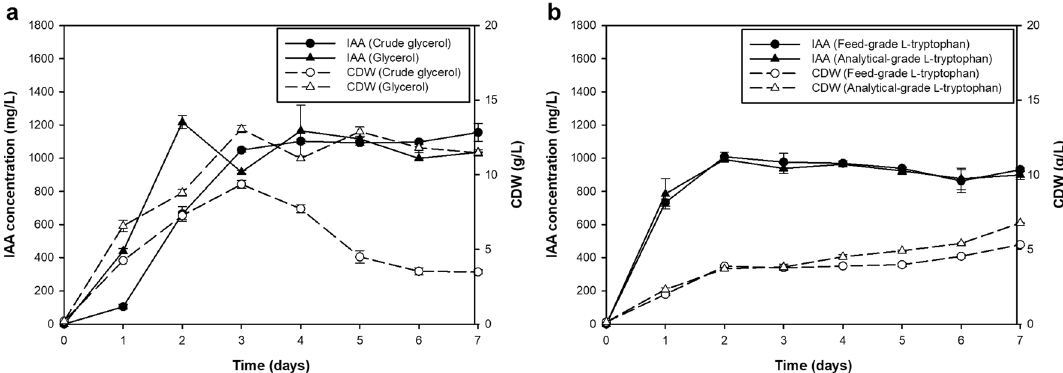
Figure 2. IAA production and cell dry weight of R. fluvialis DMKU-CP293 cultivated in a production medium containing ( a ) 2% pure glycerol or crude glycerol, 2% peptone, 1% yeast extract and ( b ) 0.1% analytical-grade l-tryptophan or feed-grade l-tryptophan in shake-flask culture at 30 °C and 200 rpm for 7